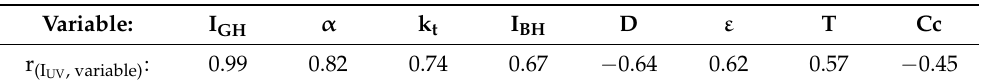
Table 1. Selection of meteorological variables to be considered, according to the Pearson correlation coefficient r(I UV ,